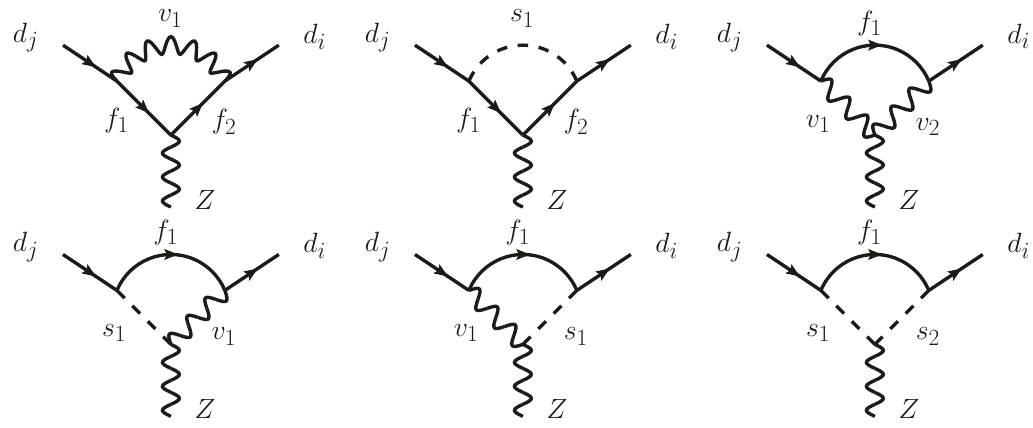
d i Z (cid:0) (cid:0)